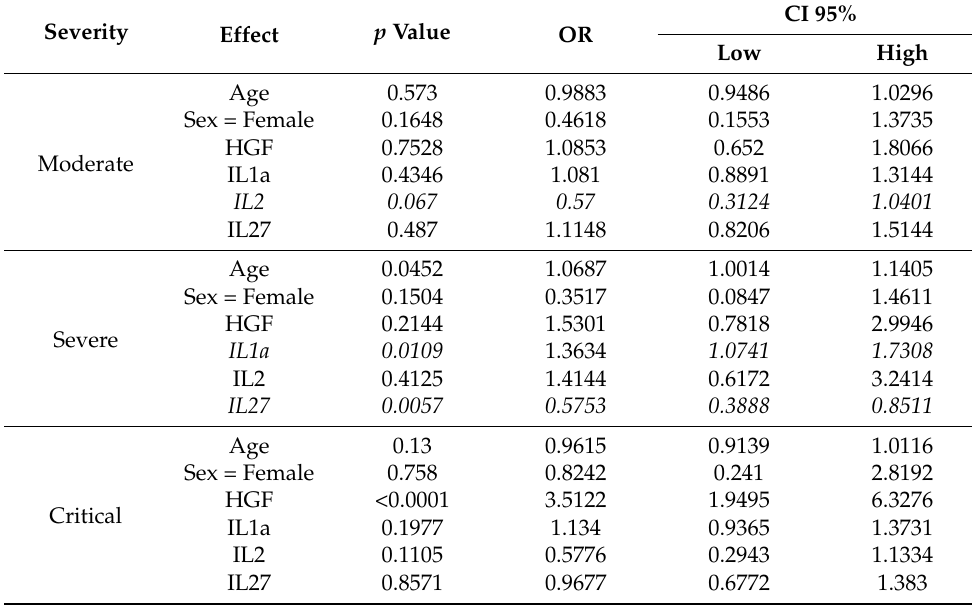
Table 3. Different multivariable models according to the degrees of